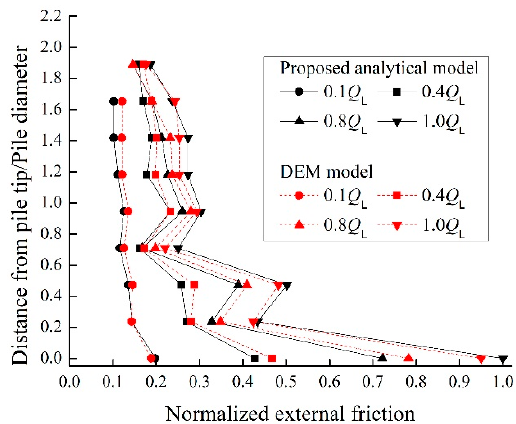
Figure 16. The external friction from the analytical method and DEM model.